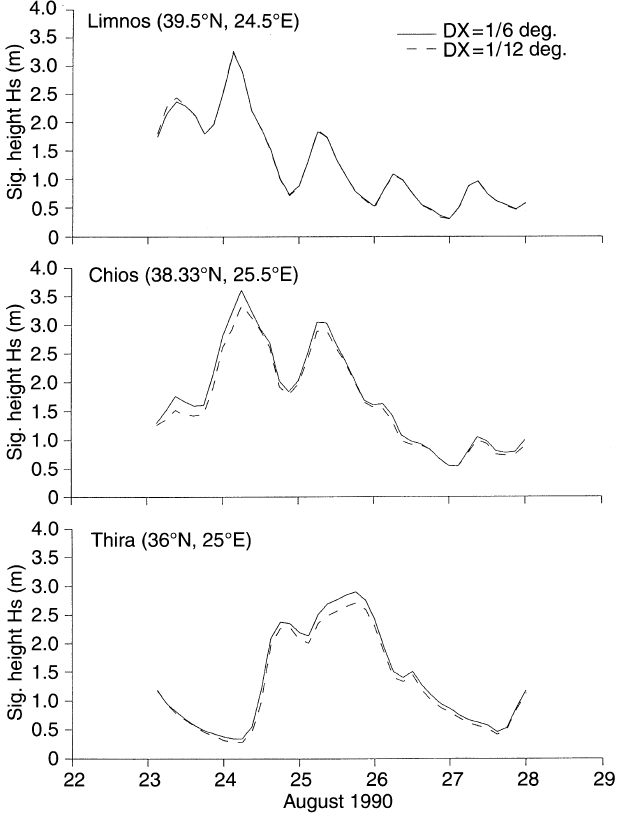
Fig. 13. Wave heights at specific grid points, August 1990 (grid 1 = 6 (cid:14) v. grid 1 = 12 (cid:14) ) WAM model